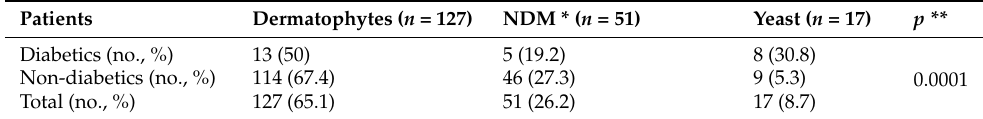
Table 3. Mycological findings in diabetic and non-diabetic